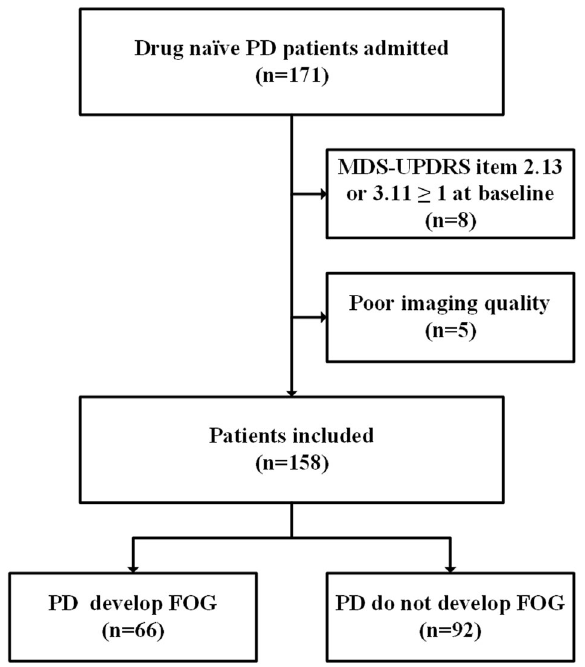
Fig. 1 Flow chart illustrating patient